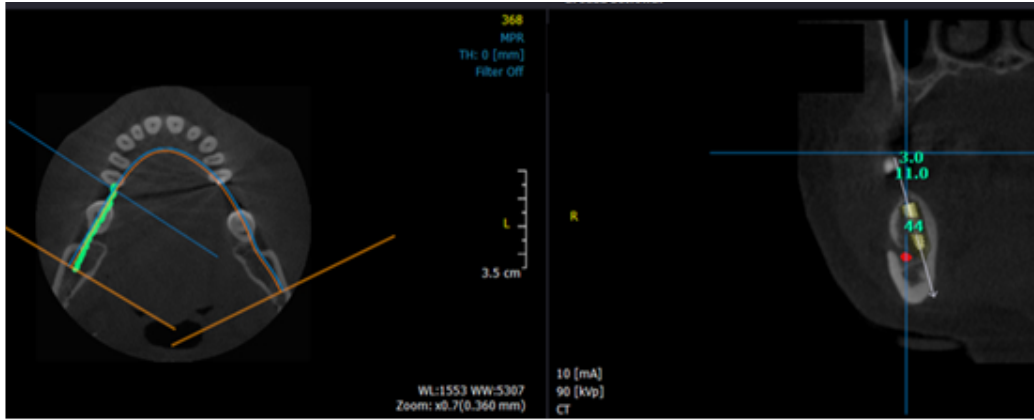
Figure 7. Inferior alveolar nerve tracing on axial plane view of CBCT and virtual implant placement by bypassing inferior alveolar nerve in cross-sectional view.